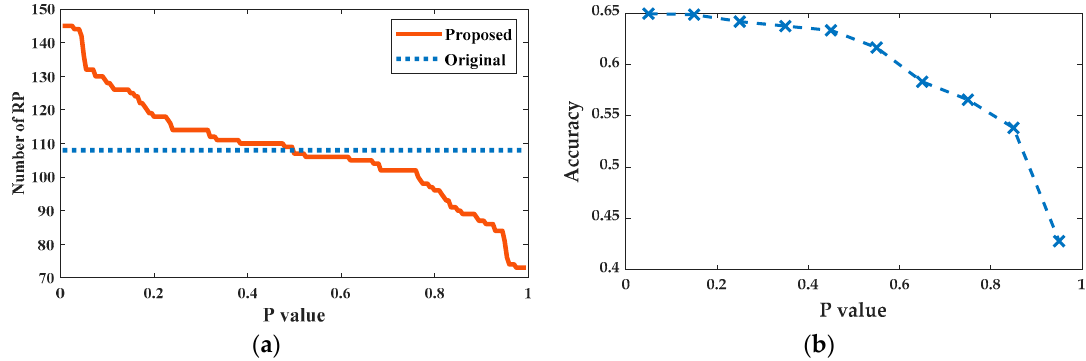
Figure 7. Area partition result. In total, 4 zones are formed after clustering, which are depicted in red, yellow, green and blue. In total, 22 RPs denoted by red triangles are located in the overlap regions. Figure 8. ( a ) Total number of RPs counted in the 4 zones generated using the proposed improved K- Means clustering algorithm. The dotted blue line shows the true RP number for comparison. ( b ) Position classification accuracy as a function of (cid:1868) .